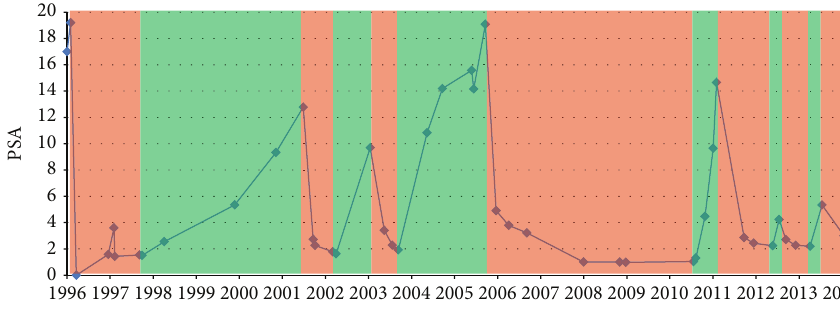
Figure 1: PSA course from 1996 to 2014. Colours illustrate therapy phases (green: off-phases 92/221 months; on-phases 129/221